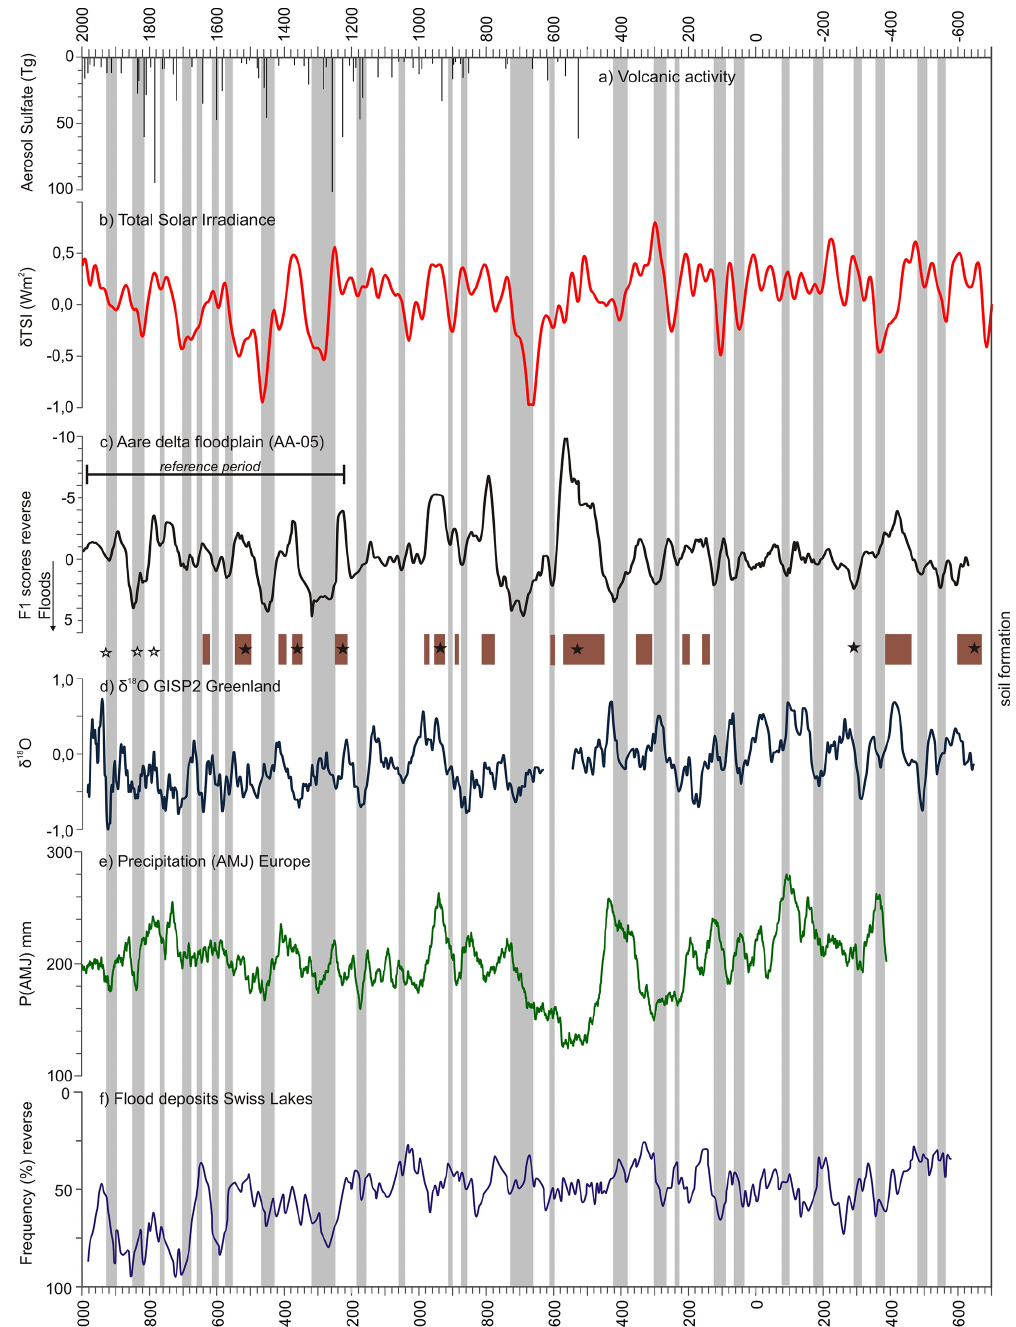
Figure 9. Comparison between reconstructed palaeofloods in the Hasli Valley and solar and volcanic activity and climate proxies from 600calyrBC to 2000calyrAD. (a) Annual stratospheric volcanic sulfate aerosol injection, Northern Hemisphere (Gao et al., 2008). (b) 40- year averaged variations of total solar irradiance (Steinhilber et al., 2009). (c) Composite sedimentary palaeoflood proxy at a 21-year resolu- tion from the Aare Delta plain in the lower Hasli Valley (this paper). Factor 1 scores of chemical composition of delta plain samples. Peat and organic soils are shown by dark shaded rectangles. Stars indicate the stratigraphical position of datings. (d) δ 18 O of the GISP2 ice core from Greenland (Stuiver et al., 1997) at a 21-year resolution. (e) 21-year smoothed AMJ precipitation anomalies in central Europe reconstructed from oak ring width series (Büntgen et al., 2011). (f) Flood chronology derived from flood deposits of 10 lakes from the northern slope and central area of the Swiss Alps (50-year moving average; Glur et al.,